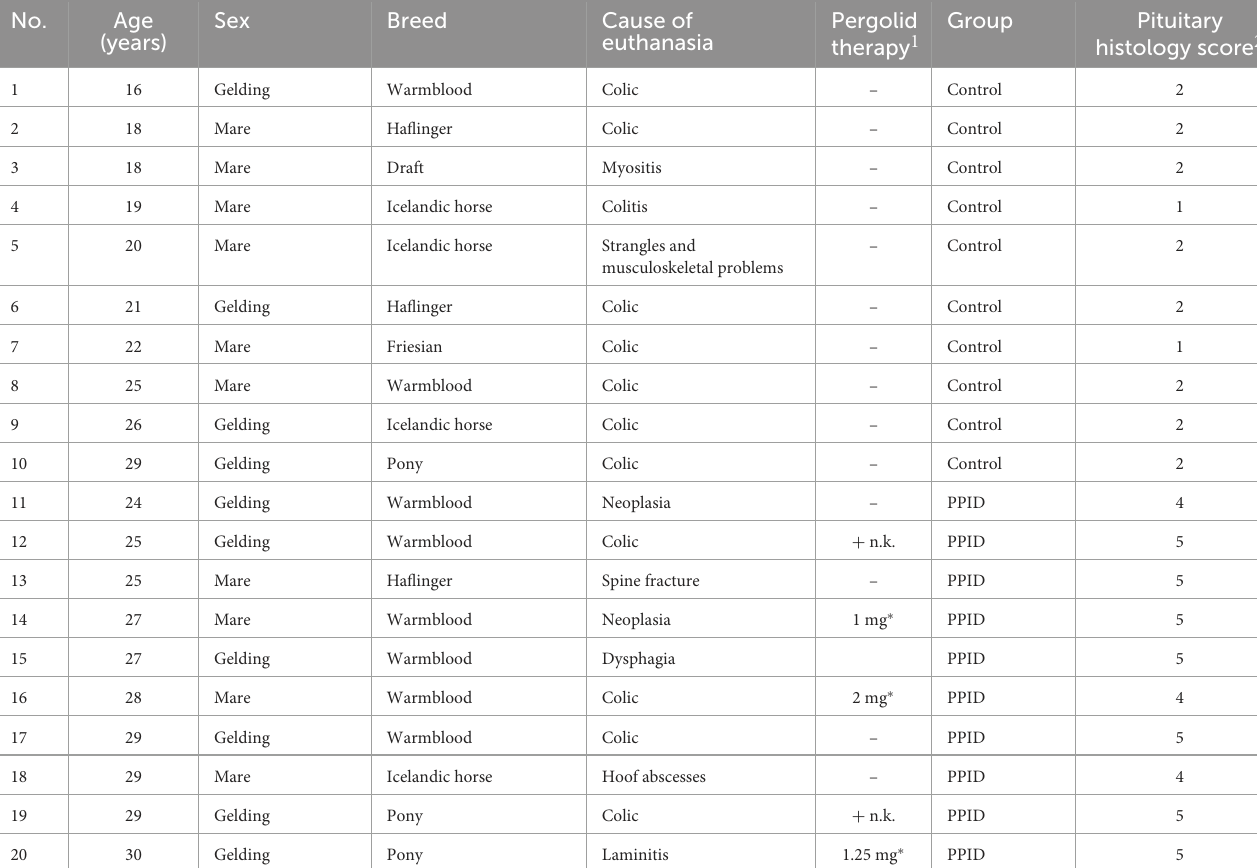
TABLE 1 Data of probands.